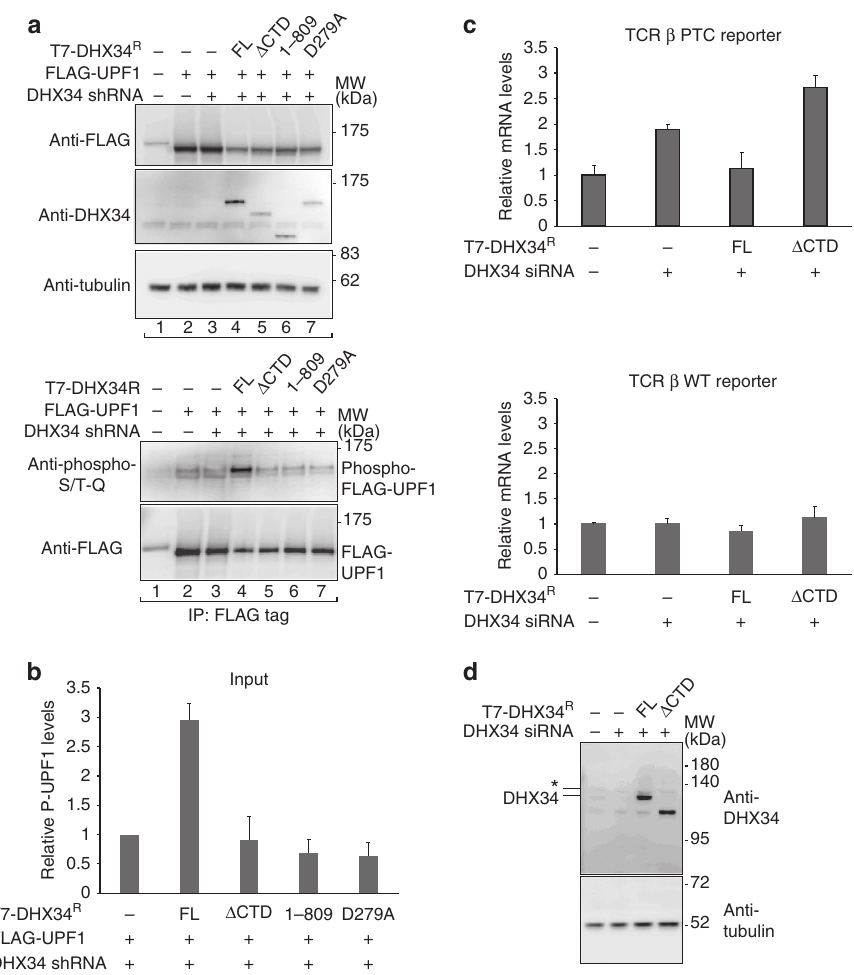
Figure 6 | The CTD domain in DHX34 is required for efficient UPF1 phosphorylation and functional NMD. ( a ) HEK293Tcells depleted of DHX34 with a specific shRNA or transfected with an shRNA targeting Luciferase ( (cid:2) ) were co-transfected with FLAG-UPF1 and shRNA-resistant full-length (FL) T7–DHX34, a mutant lacking the CTD ( D CTD), a mutant spanning residues 1–809 of DHX34 or a catalytic inactive (D279A) mutant. Phosphorylated UPF1 was detected with a phospho-(Ser/Thr) ATM/ATR substrate antibody. The phospho-FLAG-UPF1 signal was normalized to the levels of UPF1 recovered in the IP. ( b ) A quantification of the western blot signal from three independent experiments is shown. ( c ) NMD assay in HeLa cells transfected with a specific siRNA for DHX34 or a non-targeting control and two plasmids: one expressing an NMD reporter, TCR- b harbouring a PTC or a TCR- b WTreporter (lacking a PTC) and also including another plasmid expressing b -globin as a transfection control. Plasmids expressing siRNA-resistant full-length T7-tagged (FL) or mutant ( D CTD) DHX34 proteins were included, as indicated. The T7 empty vector plasmid served as a control. The levels of wild-type or PTC-containing TCR- b reporters were analysed by qRT–PCR and normalized to those of b -globin mRNA used as a transfection control. Mean values ± s.d. from three independent experiments are shown. ( d ) The expression of full-length or mutant T7–DHX34 was analysed by western blotting using an anti-DHX34 antibody. An antibody against tubulin served as a loading control. The lower band corresponds to DHX34, whereas an asterisk above indicates an unspecific band. For all panels, mean values ± s.d. from three independent experiments are shown. Error bars represent